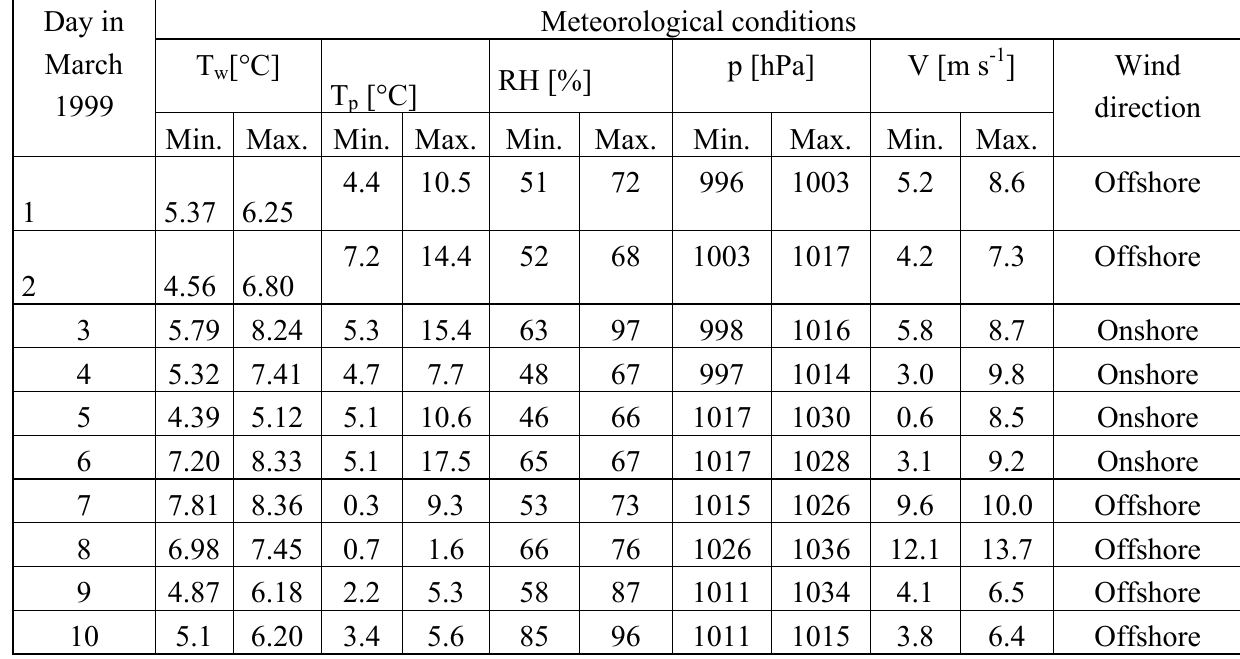
Table 3. Meteorological parameters measured during the EOPACE experiment in Duck, NC in 1999. Day